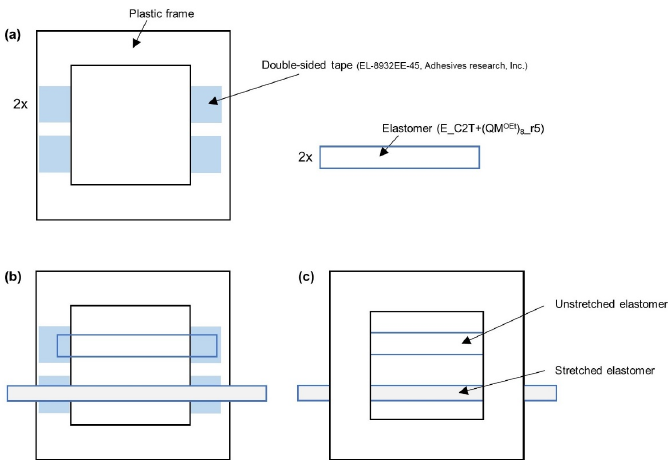
Figure A5. A schematic illustration of SEM sample preparation: ( a ) A double-sided tape was attached onto two plastic frames made of hard plastic. Two specimens 25 mm in length and 6 mm in width were cut from the elastomer film E_C2T+(QM OEt ) 8 _r15. ( b ) One of the two specimens was attached to the frame in unstretched state. The other specimen was stretched by ~100% (a sufficient strain to observe the film opacity) before attaching to the frame. ( c ) To ensure a proper specimen attachment, the second plastic frame was placed facing down by the double side tape on the top of the setup.